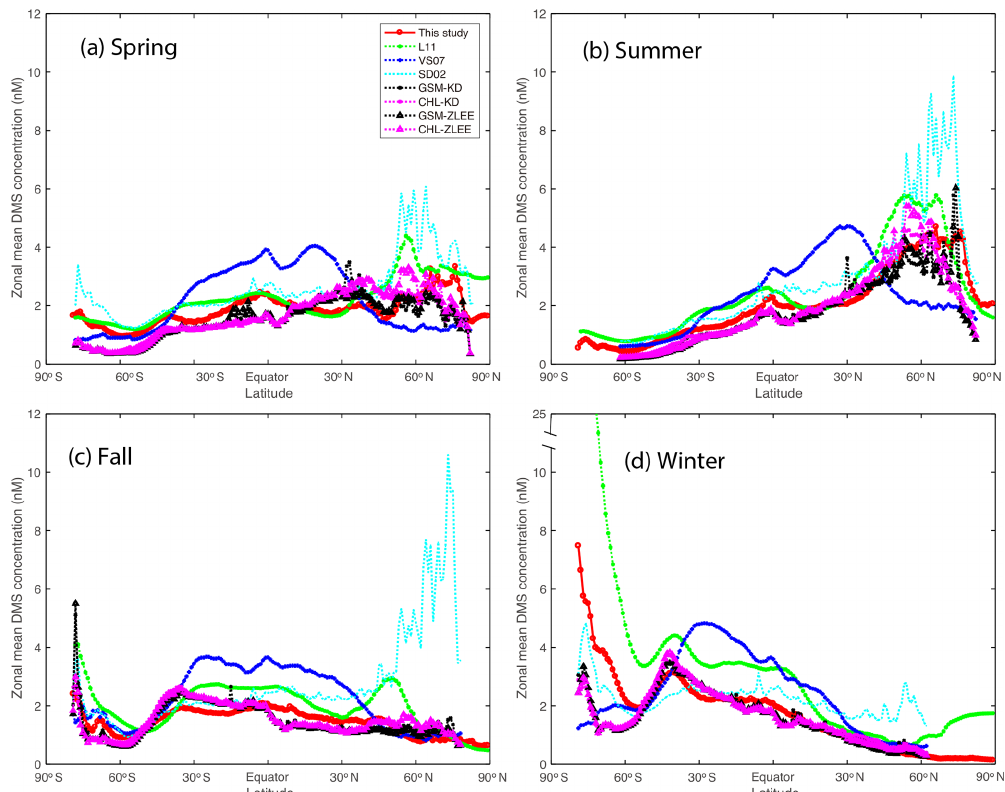
Figure 4. Comparisons of zonally mean DMS concentrations to previous studies (Simó and Dachs, 2002; Vallina and Simó, 2007; Lana et al., 2011; Galí et al., 2018). L11, SD02, and VS07 are self-explanatory. GSM-KD, CHL-KD, GSM-ZLEE, and CHL-ZLEE are the four model results from Galí et al.